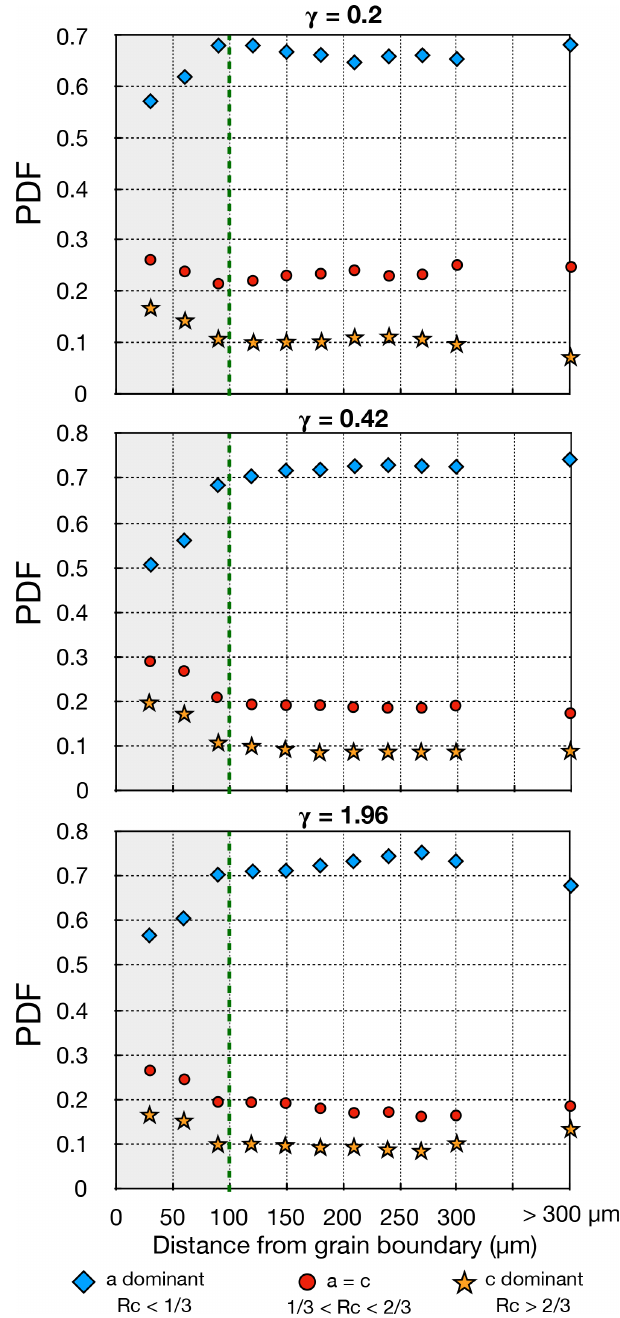
Figure 7. Probability density function for rWBV c < 1 / 3 (blue dia- monds), 2 / 3 < rWBV c < 2 / 3 (red circles) and rWBV c > 2 / 3 (yel- low stars) components of the GNDs across profiles from grain boundaries to cores of the GNDs, extracted from WBV maps, for TGI0.2, TGI0.42 and TGI1.96. The green dotted line represents the 100µm distance to the grain